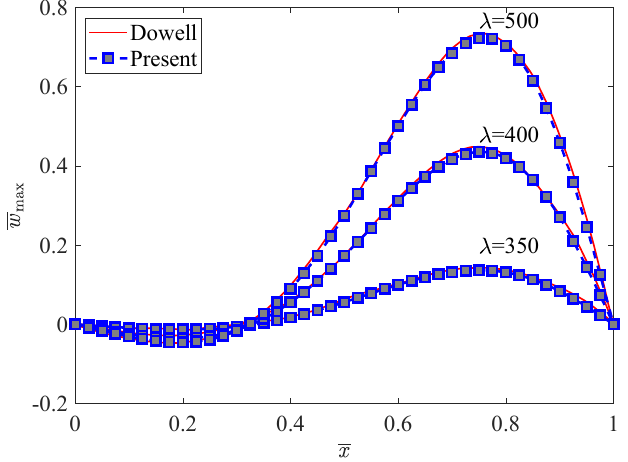
Figure 5. Panel deflection shapes.